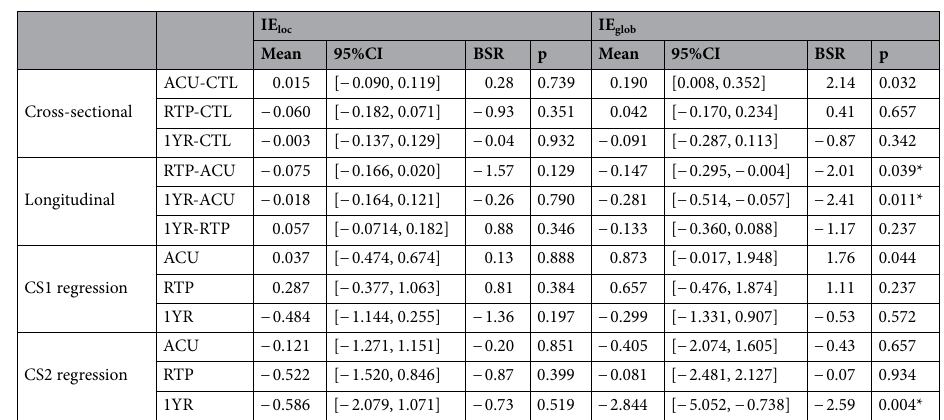
Table 2. Effects of concussion on integrated local efficiency ( IE loc ) and integrated global efficiency ( IE glob ), for concussed athletes at acute injury (ACU), return to play (RTP) and one year post-RTP (1YR). This includes cross-sectional differences relative to controls (CTL) and within-subject longitudinal changes between imaging sessions. Tables report mean effects with bootstrapped 95% confidence intervals (95% CIs), bootstrap ratios (BSRs) and p-values. Significant effects at an FDR threshold of 0.05 are noted with ‘*’.